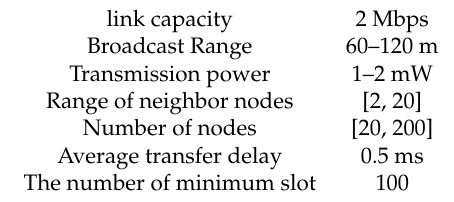
Figure 7. The Topology Structure. Table 1. Simulation